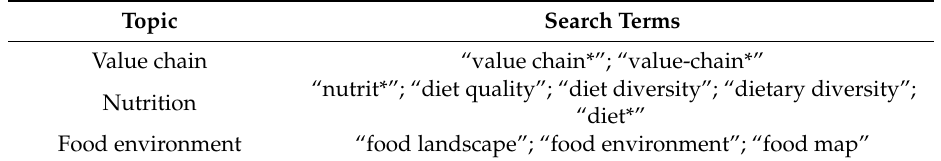
Table 1. Search terms used in the review of value chains and nutrition. The asterisk serves as a truncation operator. Words match if they begin with the word preceding the *